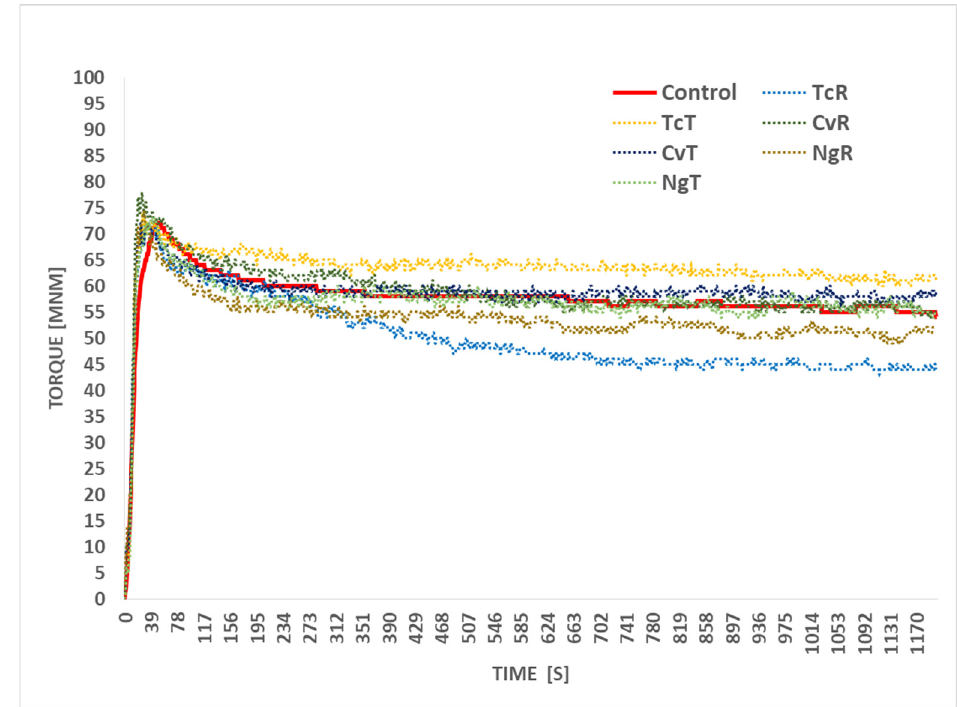
Figure 1. Representative farinograph mixing curves acquired from the gluten-free dough (control) and the ones with 4% replacement of Tetraselmis chuii (TcR), Tetraselmis chuii ethanol-treated (TcT), Chlorella vulgaris (CvR), Chlorella vulgaris ethanol-treated (CvT), Nannochloropsis gaditana (NgR) and Nannochloropsis gaditana ethanol-treated (NgT). Table 2. Mixing properties acquired from Micro-doughLab curves of the control and the microalgae biomass-enriched gluten-free breads: water absorption (WA), dough development time (DDT), and dough stability (DS).